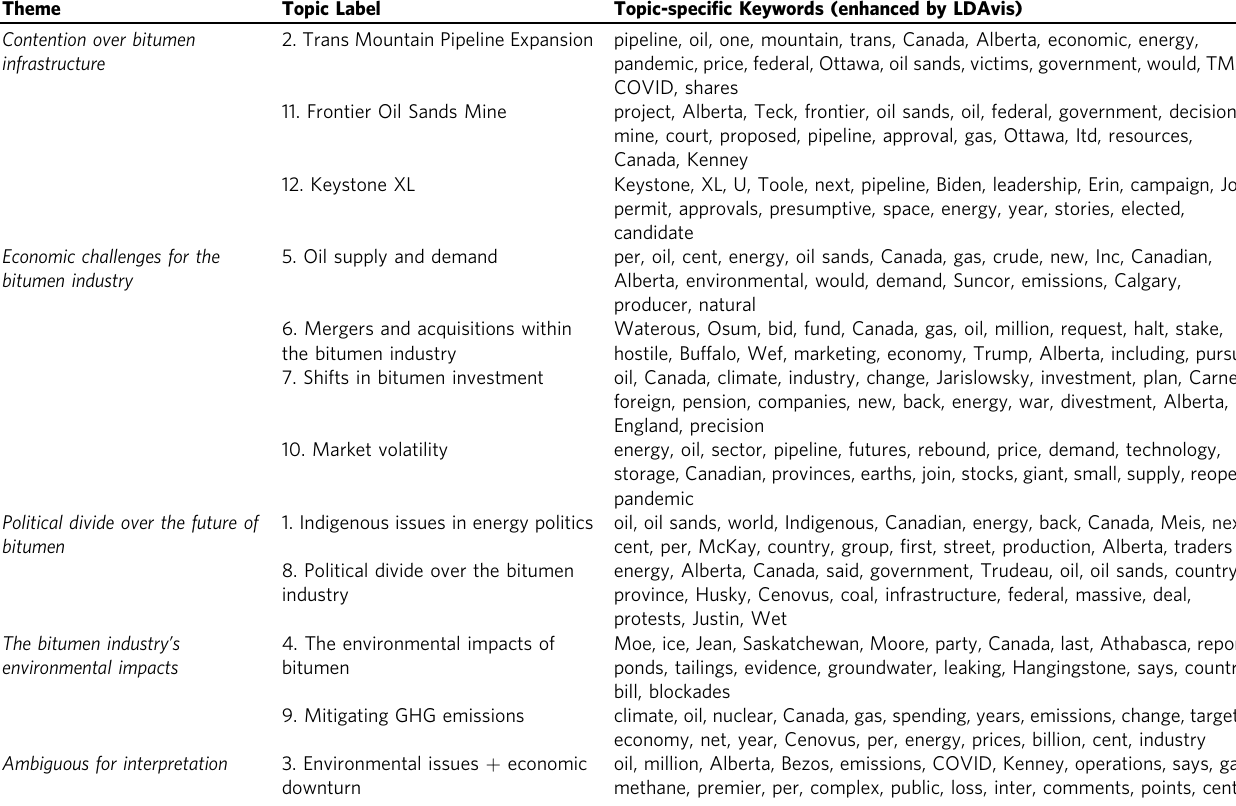
Table 2 Top-weighted words of topic modeling